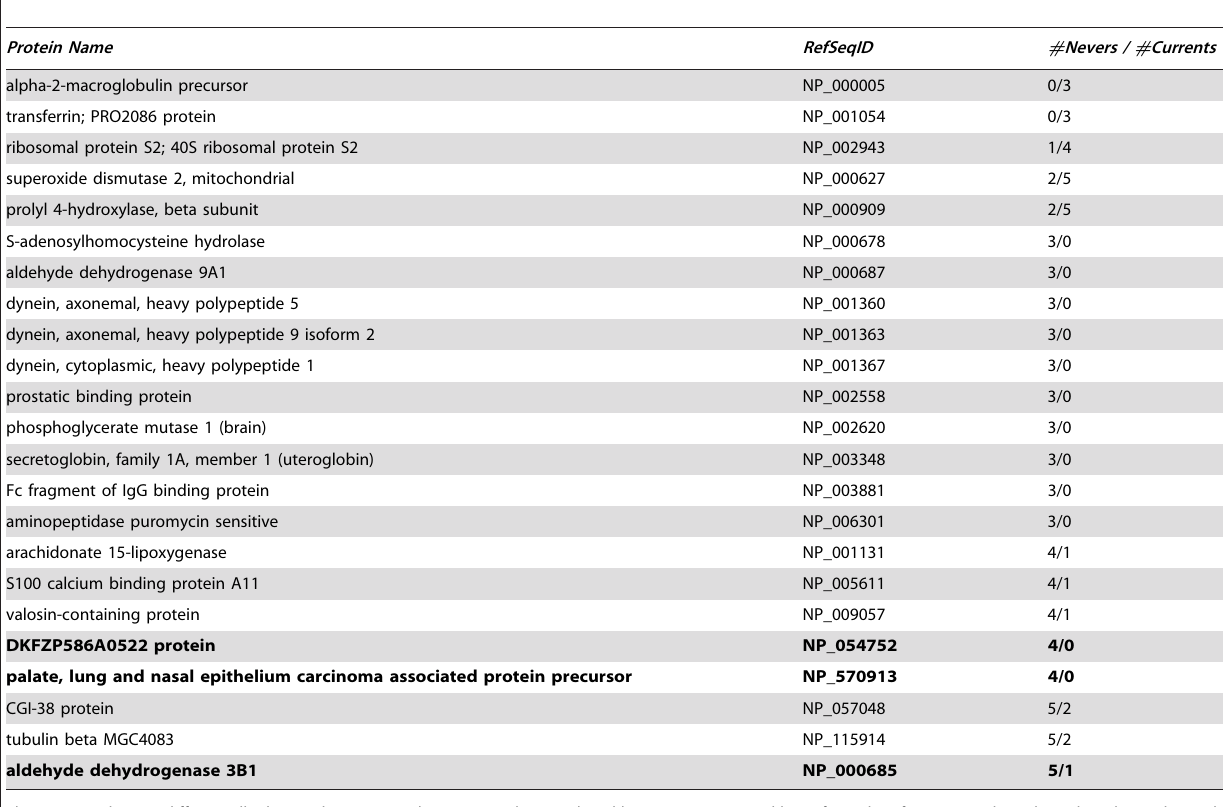
Table 3. Proteins differentially detected in the airway of never and current smokers by mass